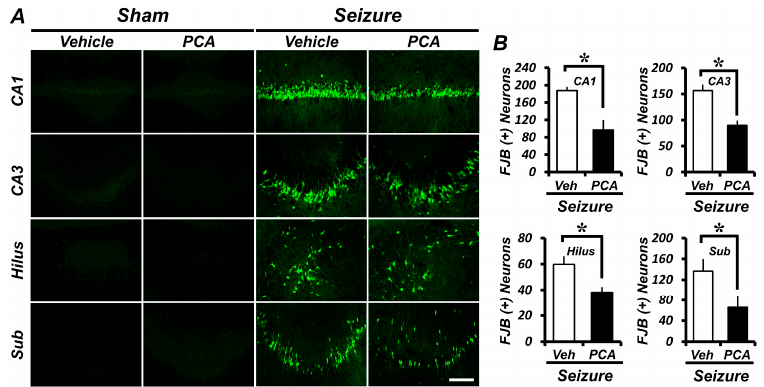
Figure 1. The protocatechuic acid (PCA) treatment reduces the number of degenerating neurons after a seizure. Three days of the PCA treatment reduces the number of seizure-induced degenerating neurons. Fluoro-Jade-B (FJB) staining was performed to visualize the degenerating neurons. ( A ) A series of photographs showing degenerating neurons in the control group and the PCA-treated group after a seizure. Scale bar = 100 μ m. ( B ) The graph represents the number of FJB + neurons in the hippocampus after a seizure. Data: mean ± standard error of the mean (SEM), n = 5–7 from each group. * p < 0.05. Veh = Vehicle; CA1 and CA3 = Cornu Ammonis 1 and 3 of the hippocampus area; Sub = Subiculum. 2.2. PCA Treatment Preserves Neuronal Glutathione (GSH) Loss in Hippocampal Neurons GSH levels were assessed in hippocampal pyramidal neurons by staining with glutathione with N -ethylmaleimide (GS-NEM) to confirm changes in GSH content. Compared to the sham group, the GSH level was significantly reduced in the seizure-induced group. The GSH concentrations in the PCA-treated group showed that, compared to the vehicle-treated group, there was a preservation of pyramidal neurons in CA1 (Figure 2). As shown in Figure 2B, in the hippocampal CA1 region, the GSH level decreased by 58% in the seizure-vehicle-treated group when compared to the sham- vehicle-treated group. On the other hand, the seizure group treated with PCA had a GSH level only 37% lower than the sham-vehicle-treated group. GSH levels were increased by 48% in the seizure PCA-treated group when compared to the seizure vehicle-treated group.